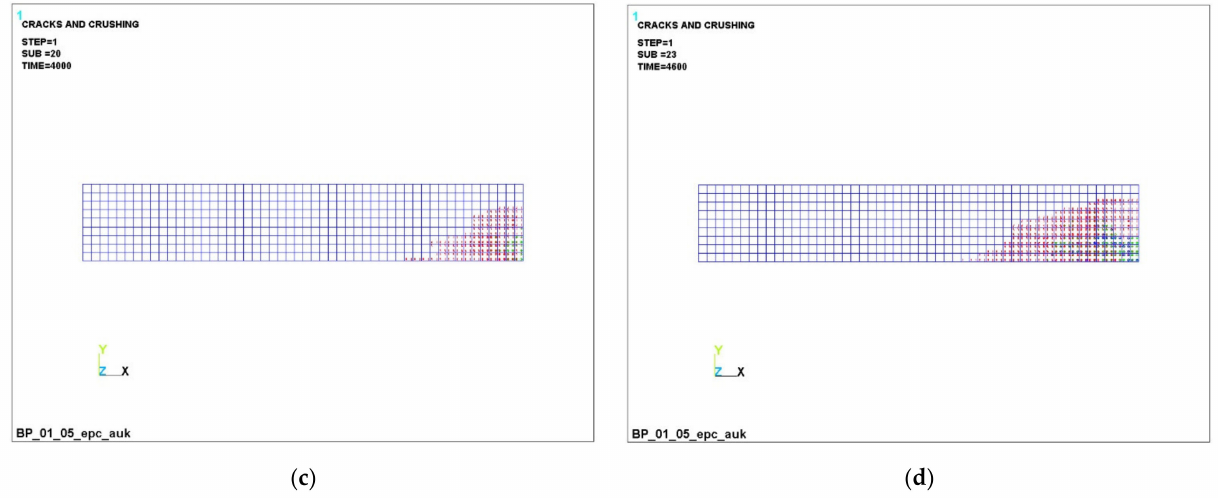
Figure 10. Successive cracking in concrete with CCR under load: ( a ) –3000 N; ( b ) –3400 H; ( c ) 4000 H; ( d ) –4600